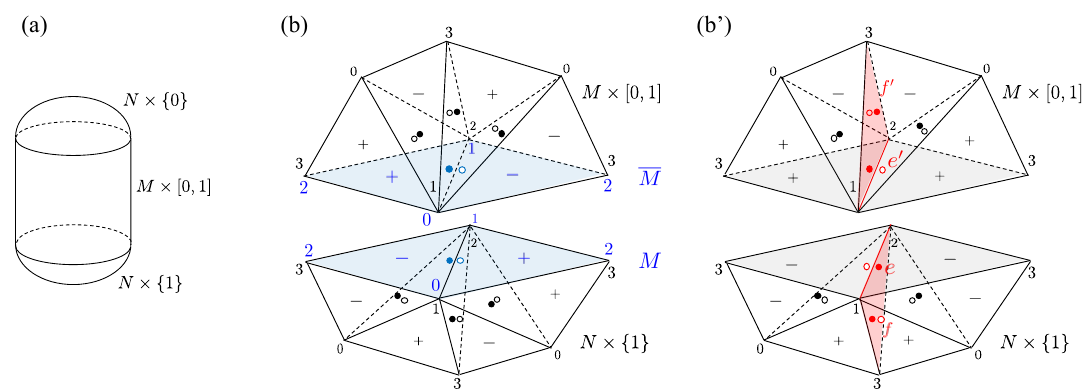
Figure 4 . (a): an example of K such that @K = ( N (cid:2) f 0 g ) t ( M (cid:2) [0 ; 1]) t ( N (cid:2) f 1 g ). (b): away from the orientation reversing wall, the colors of Grassmann variables on M match those of M